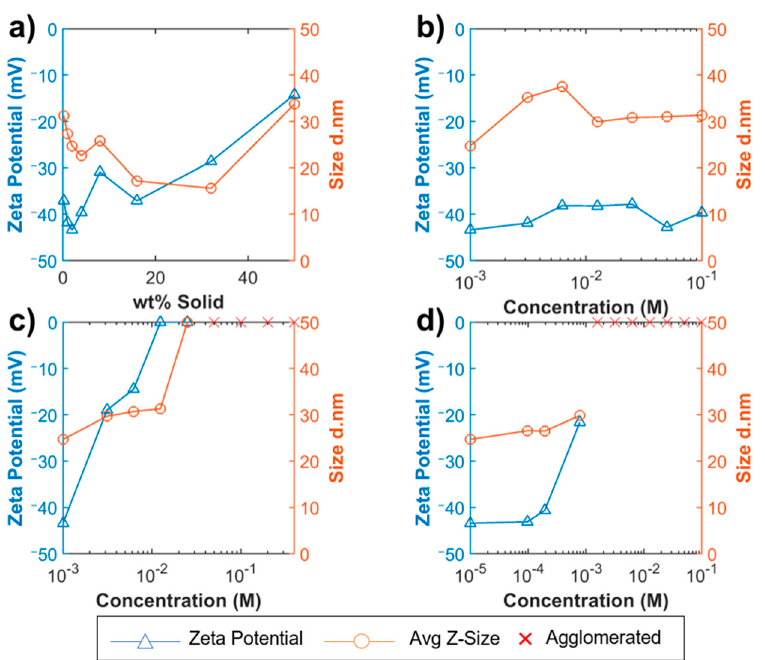
Figure 7. ZP and size measurements for NS-20b: ( a ) solid concentration varied with DI water; ( b ) potassium hydroxide concentration varied with DI water; ( c ) calcium nitrate concentration varied with DI water; ( d ) pore solution concentration varied with DI